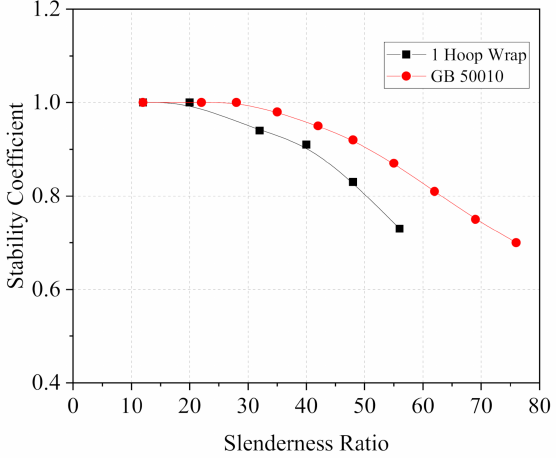
Figure 7. Stability coefficient versus slenderness curves.